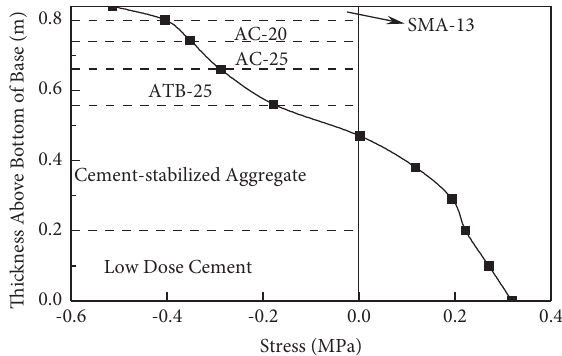
Figure 18: Maximum tensile stress position of surface.